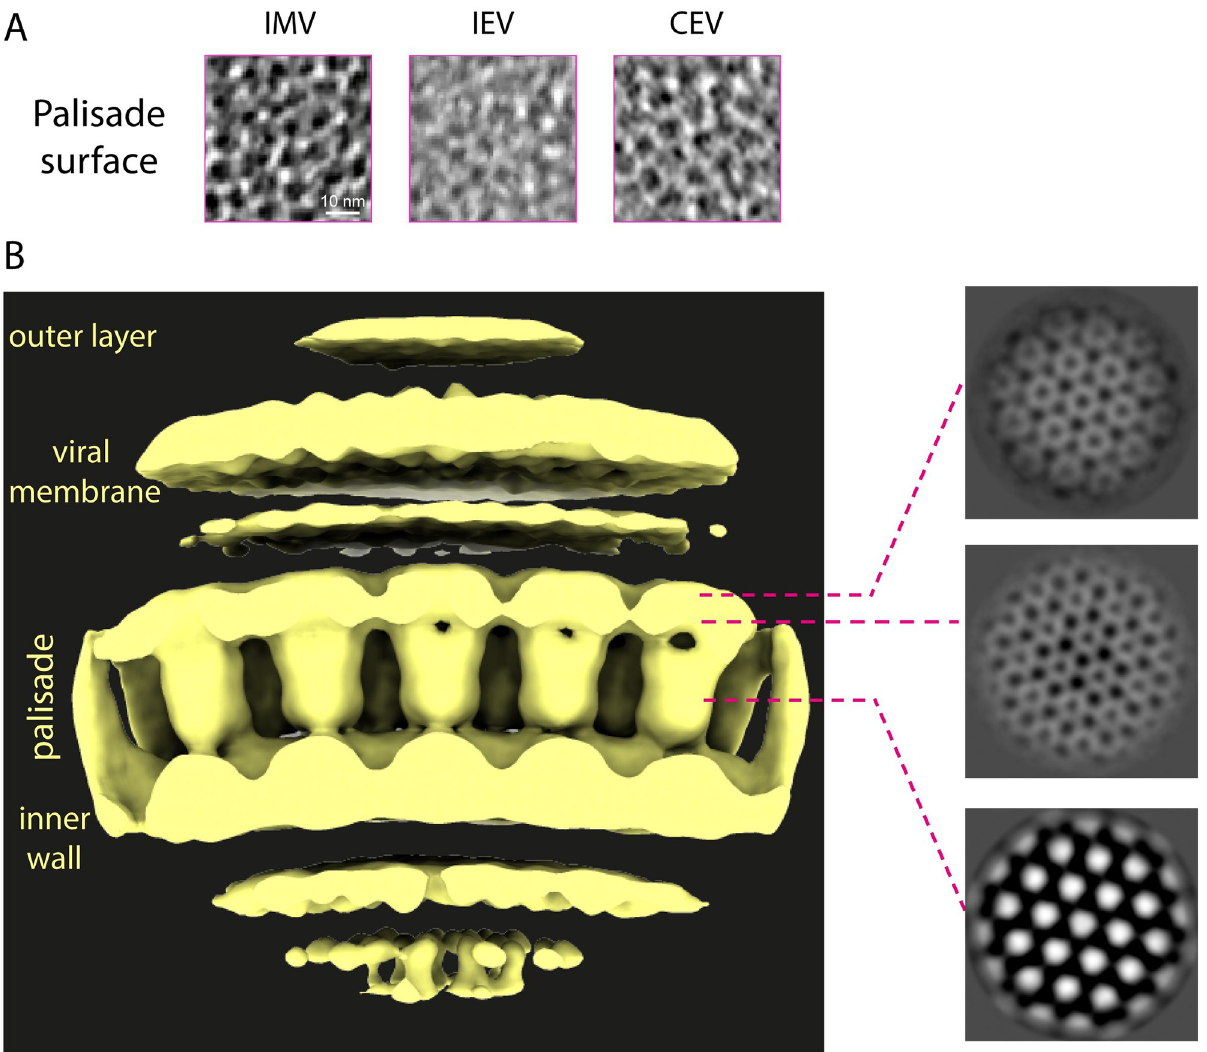
Fig 8. The palisade is a pseudohexagonal lattice composed of trimeric proteins. ( A ) Sections through the palisade layer corresponding to the virions shown in Fig 7A. Scale bar = 10 nm. ( B ) Map derived from STA showing the inner wall, palisade layer, viral membrane, and outer layer in surface representation (left) and corresponding sections of the map (right, greyscale). CEV, cell-associated enveloped virus; IEV, intracellular enveloped virion; IMV, intracellular mature virion; STA, subtomogram